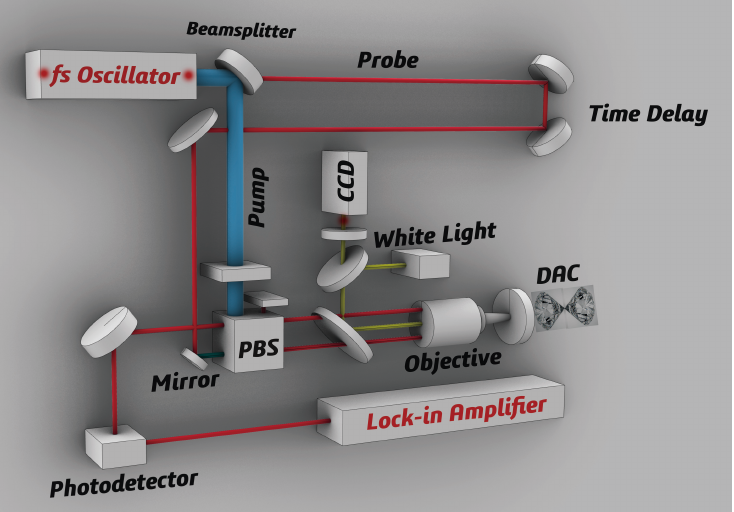
Figure 1. Schematic blocks of the high-pressure femtosecond spectroscopy setup. The laser is separated into pump and probe beamlines. The probe beamlines undergo a time delay. The block PBS denotes the polarized beam